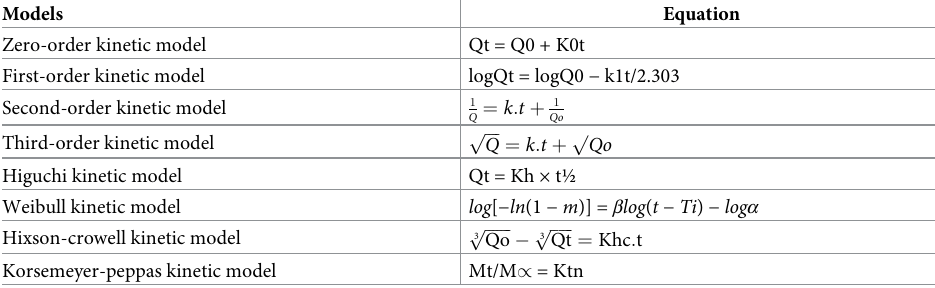
Table 3. Mathematical models for comparison of dissolution profiles azithromycin tablets.